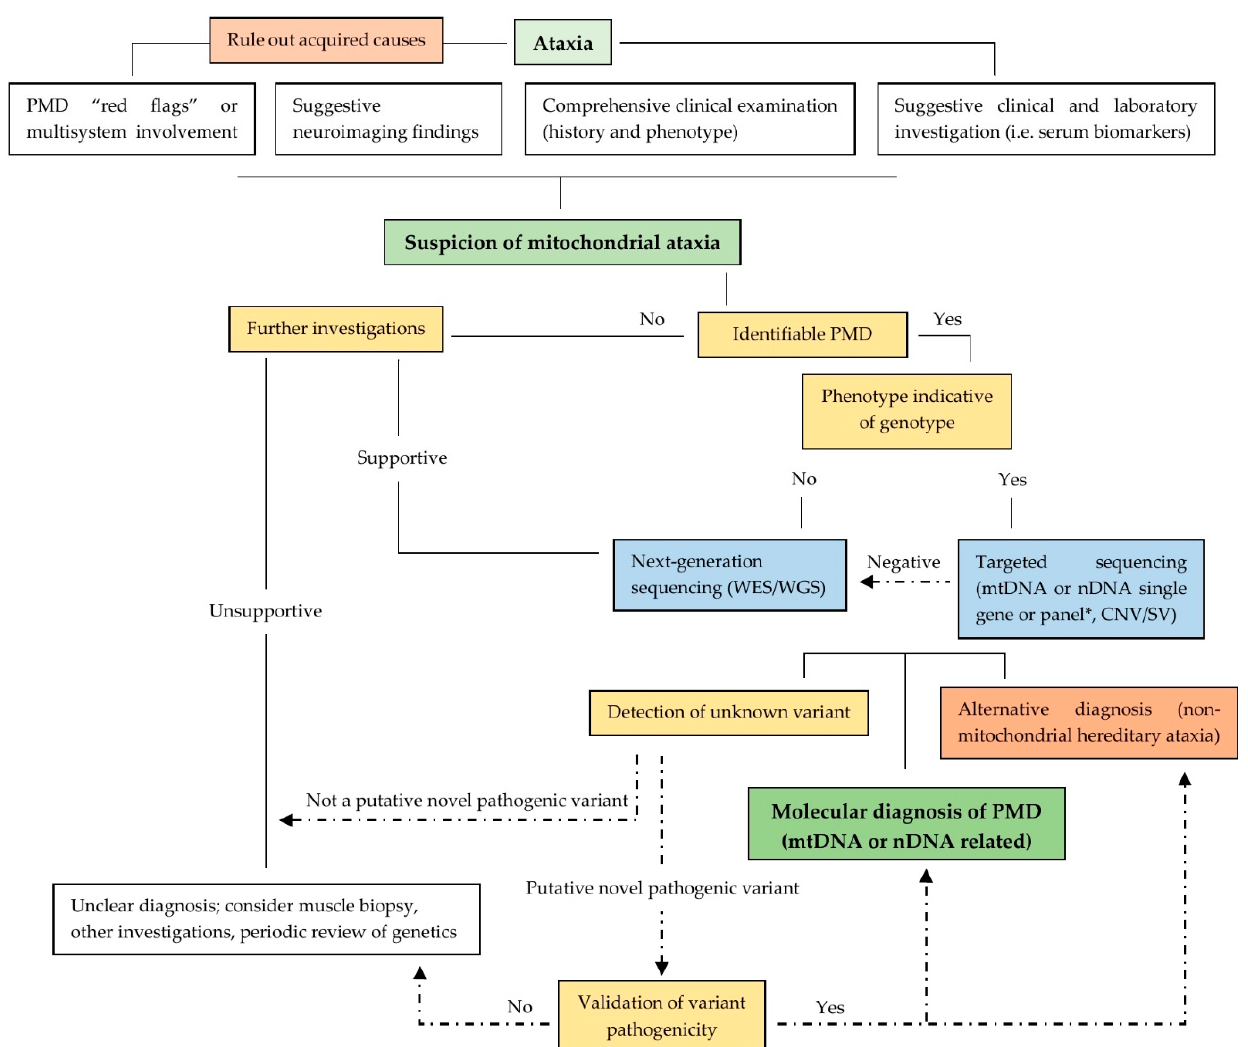
Figure 1. Diagnostic algorithm for mitochondrial ataxias. CNV/SV: copy number variants/structural variations. * In the case of a dominant family history, firstly screen for SCA 1,2,3,6,8,17 and denta-